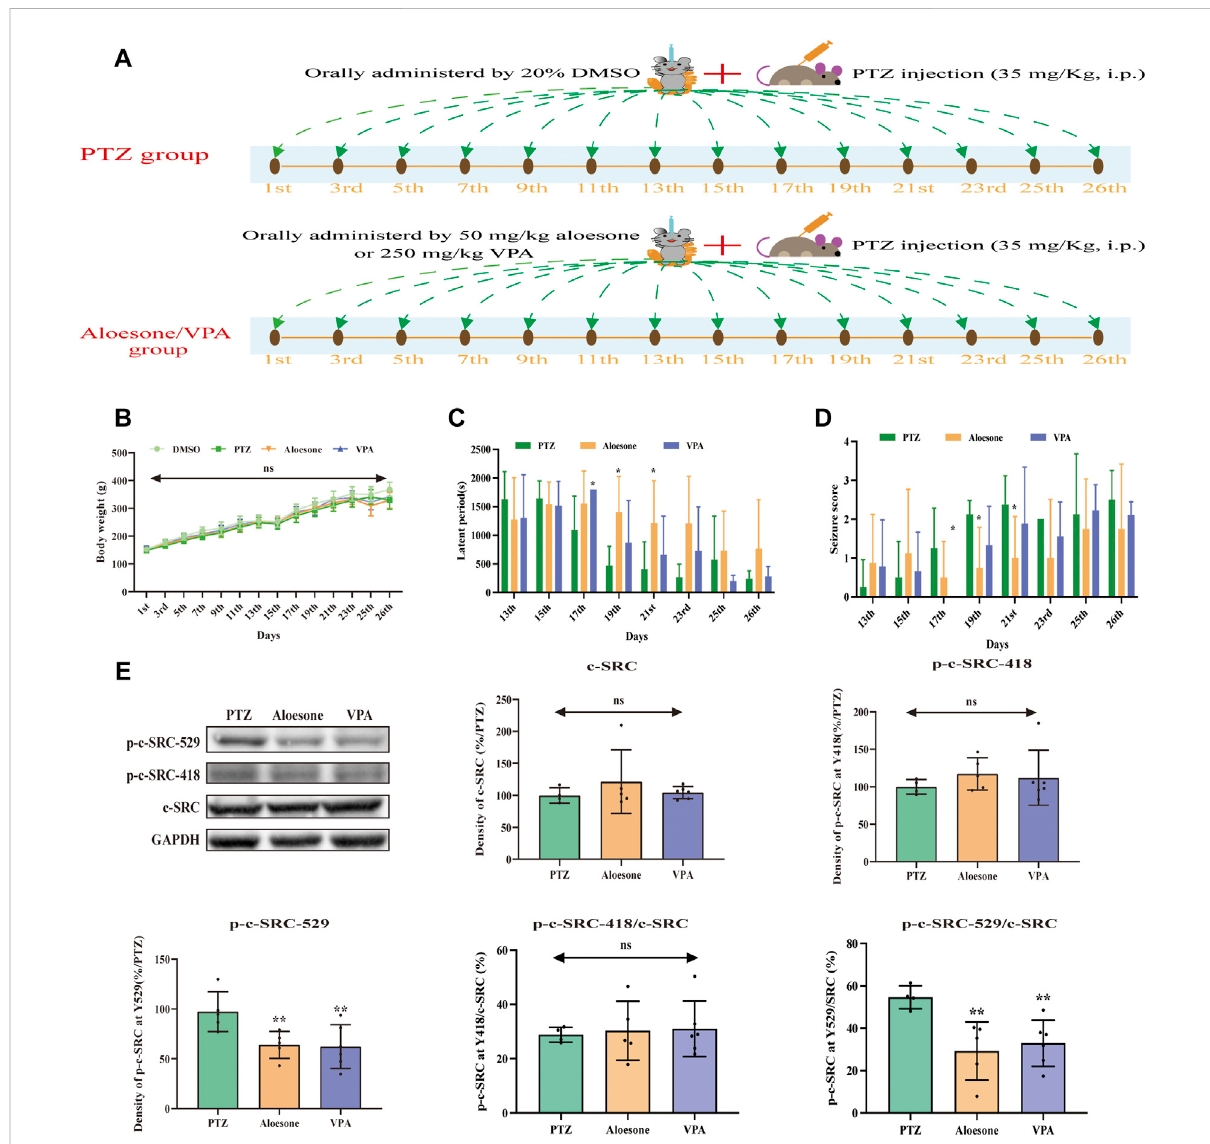
FIGURE 5 Effects of aloesone (50 mg/kg) on PTZ-induced chronic seizures. (A) Procedure ofinducing chronic seizures with PTZ. (B) Body weights of rats administered 20% DMSO, PTZ, aloesone (50 mg/kg), or valproic acid (VPA, 350 mg/kg). (C) Latent periods in the PTZ, aloesone, and VPA groups.